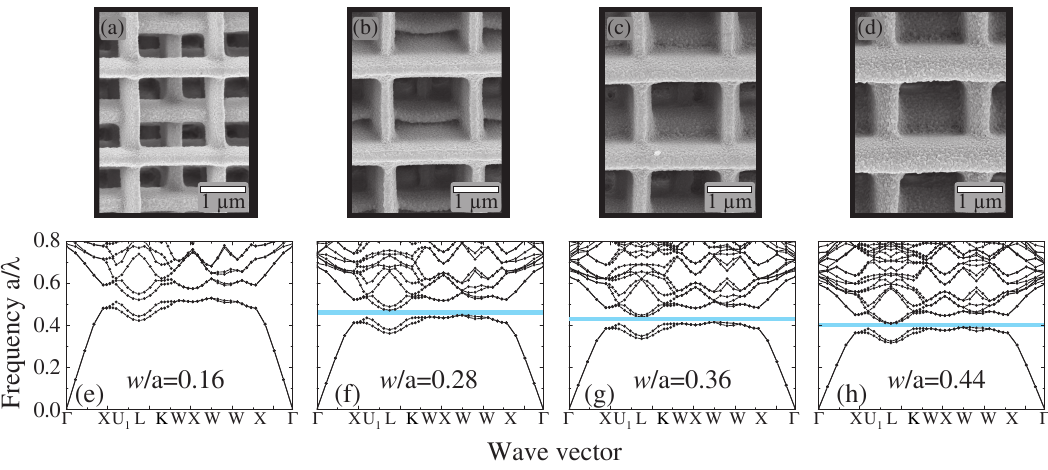
( a – d ) Woodpile crystals with different filling factors and the photonic band structures ( e – h ) calculated for materials with the relative permittivity ε = 6 in the air surrounding them. Wave vectors are given for a region of the irreducible Brillouin zone, which includes the edges of the complete photonic band gap. The regions of the complete photonic band gap are marked with